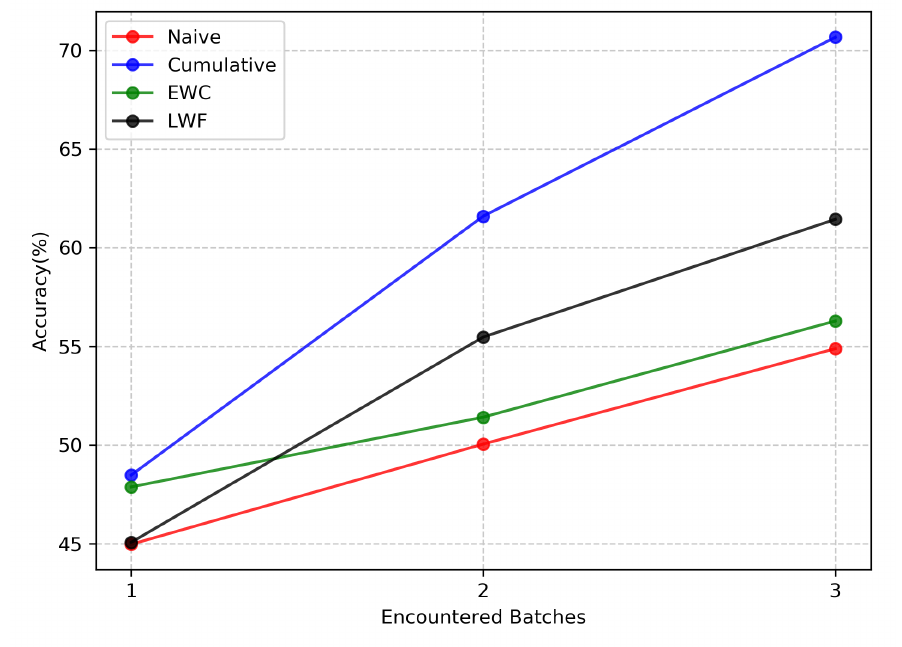
Figure 10. Test accuracy of the four methods on the New Instances (NI) scenario. The final result of each method is the average of disturbing the training batches order five times. EWC = Elastic Weights Consolidation; LWF = Learning Without